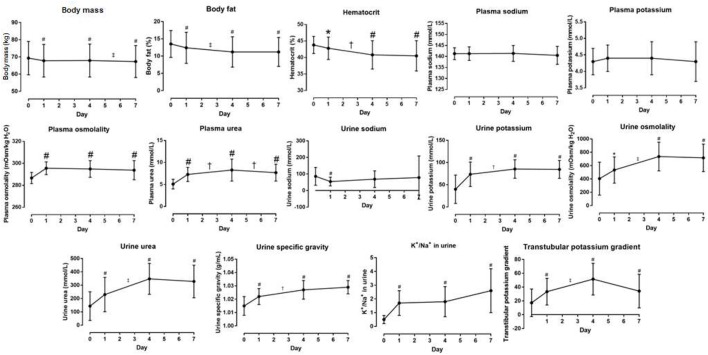
Body composition, blood and urine data and their changes. Symbol # denotes difference from day 0 = B1 (before stage 1) at p < 0.01. Symbols † and ‡ denote differences between two days at p < 0.05 and p < 0.01, respectively.